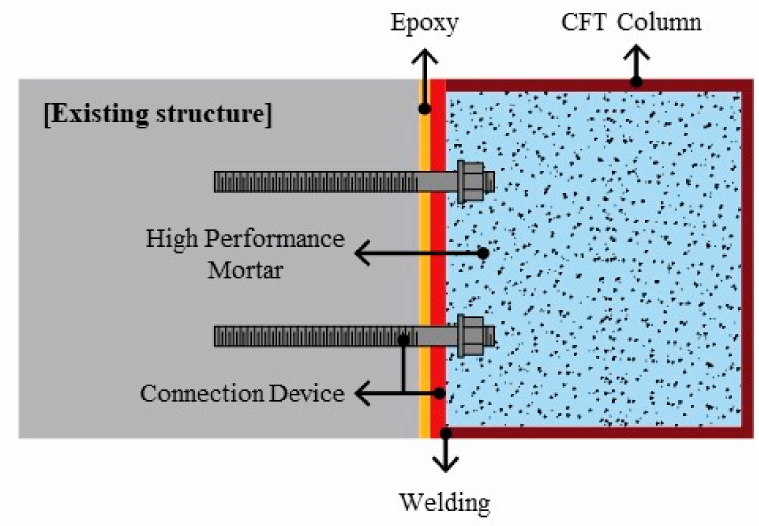
Figure 3. Conventional CFT column connection method.